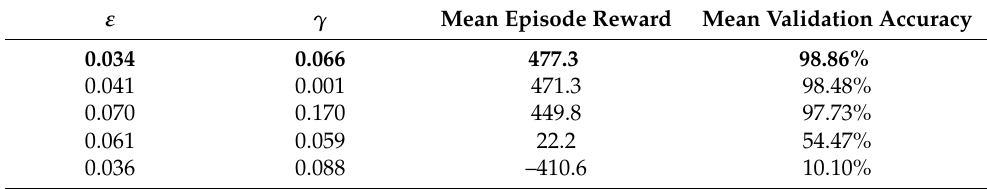
Table 14. Experiment results (averaged over the last 10 episodes) without